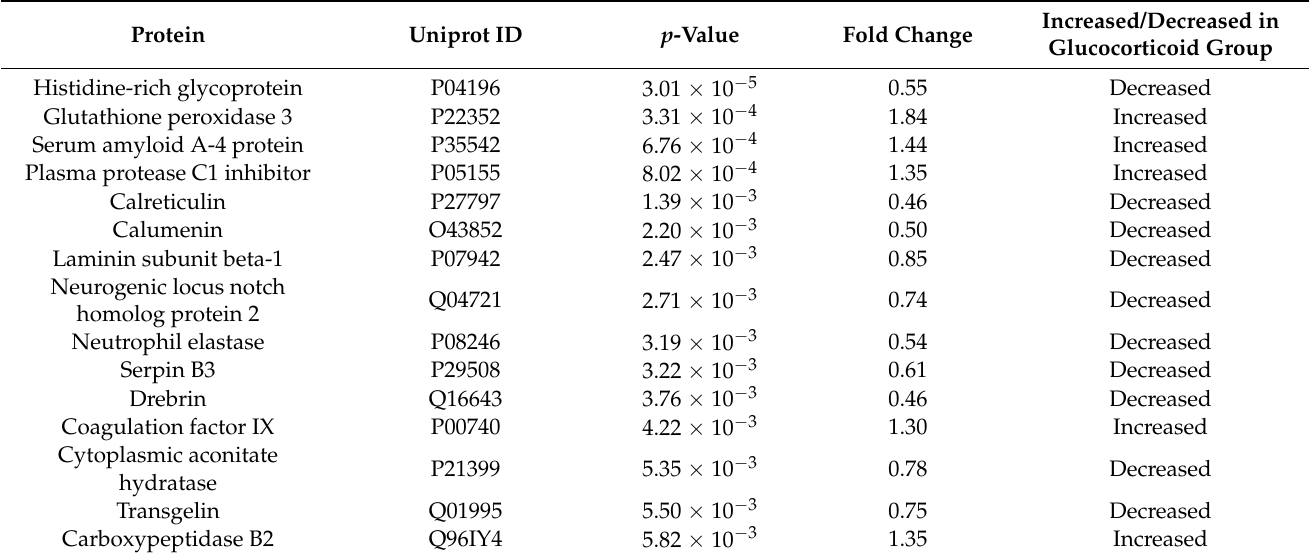
Table 3. Top 15 proteins ranked by p -value different between treated and untreated cohorts measured by the Wilcoxon rank sum non-parametric test.